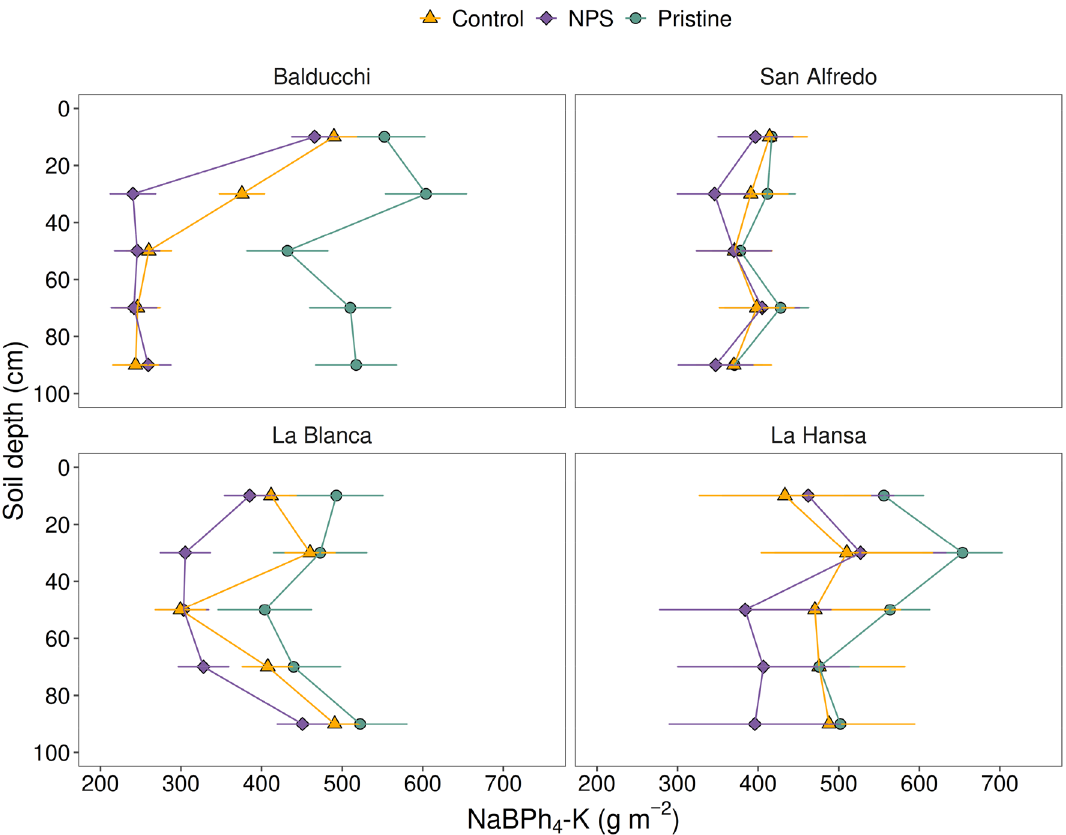
Figure 3. Soil profiles of NaBPh 4 -K (g m −2 ) under three different scenarios: pristine soils (green circles), under grain cropping from 2000 to 2009 with no fertilizers added (Control, orange triangles), and under grain cropping from 2000 to 2009 with N, P, plus S fertilization (NPS, purple diamonds). Overlapping error bars indicate absence of significant differences between scenarios by soil depths combinations (Tukey’s HSD, p <